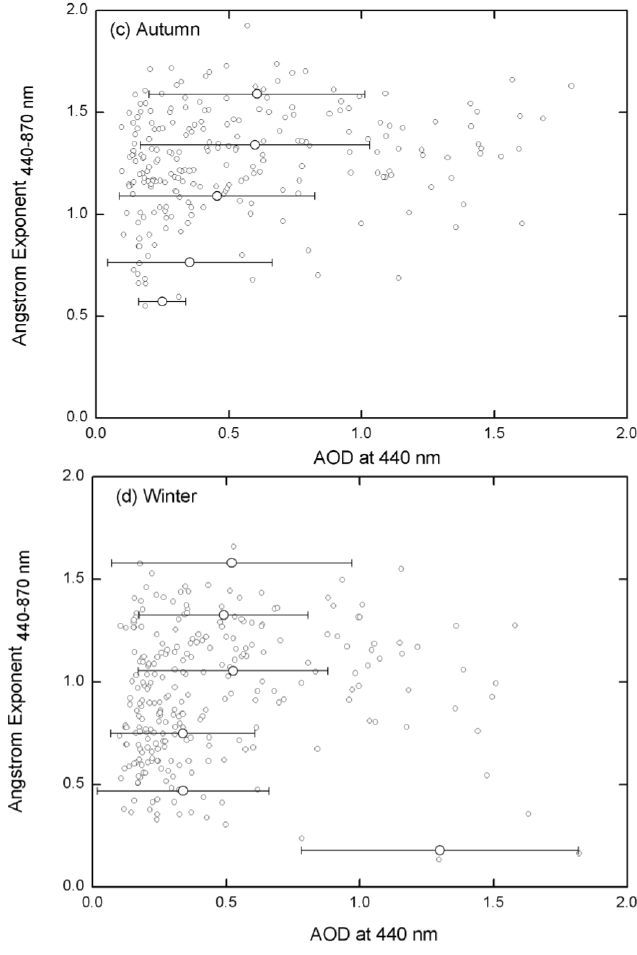
Figure 6. Scatter grams of the daily AOD and Å ngström exponents at Dalian monitoring station in ( a ) spring; ( b ) summer; ( c ) autumn; and ( d ) winter.